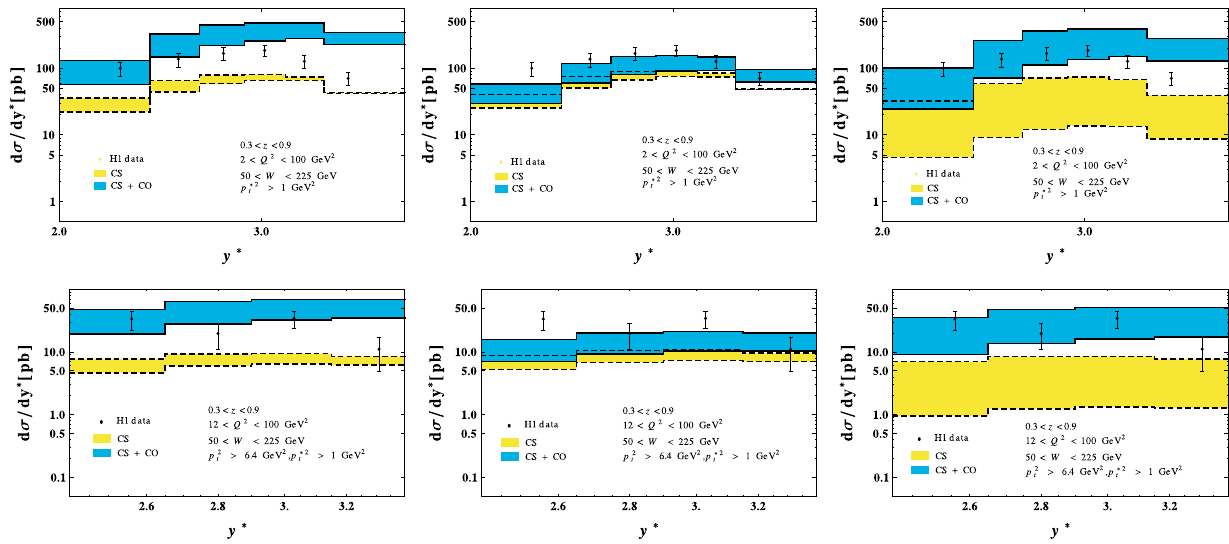
Fig. 12 The differential cross sections for the J /ψ production in DIS with respect to y ψ . The experimental data are taken from Ref. [49]. The l.h.s., middle, and r.h.s. plots correspond to the LDMEs taken in Refs. [28,30,41], respectively